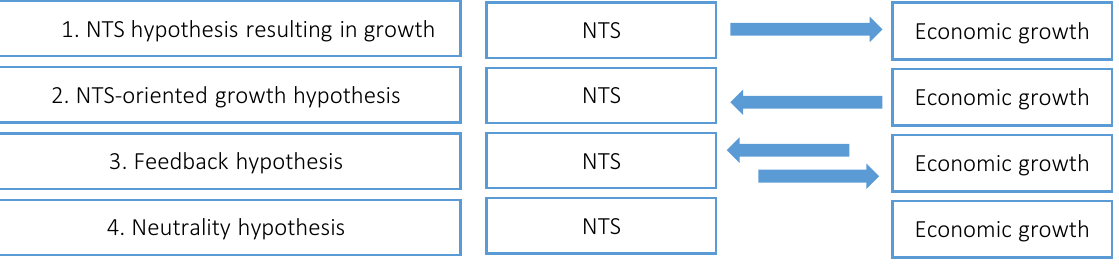
Figure 1. The semantics of hypotheses on the NTS an economic growth